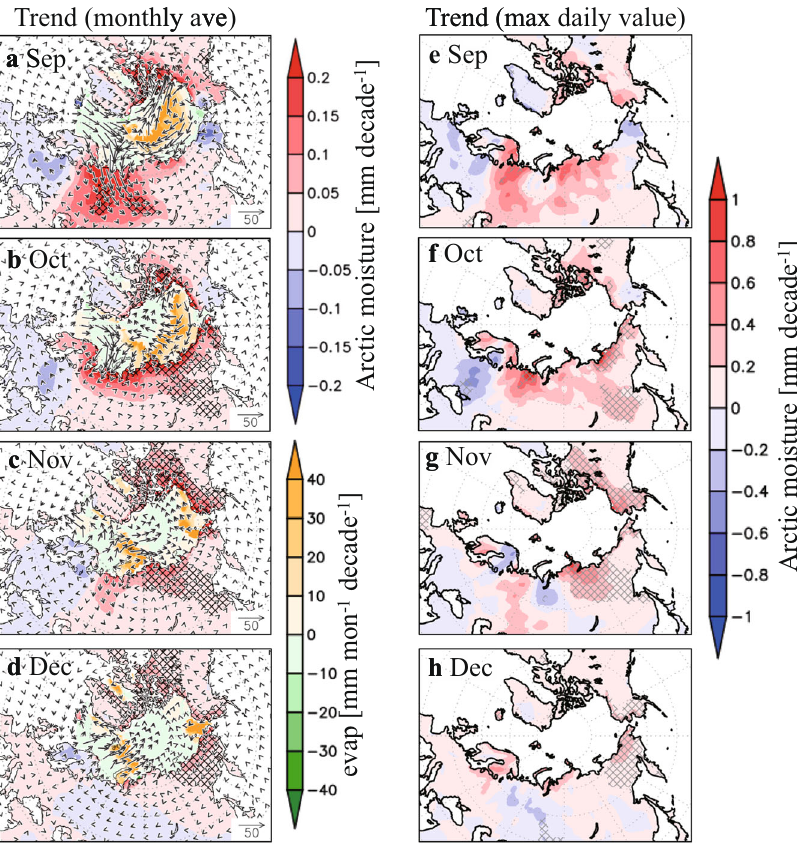
Fig. 4 Trend of monthly-mean Arctic moisture. a – d Linear trends of Arctic moisture for each month (shading over land; mm decade − 1 ) and evaporation (shading over the Arctic Ocean; mm month − 1 decade − 1 ). Vectors are as described in Fig. 3 but for each month. e – h Linear trends of daily Arctic moisture content in terms of their highest value in each year (mm decade − 1 ). Hatching denotes a trend signi fi cant at the 95% con fi dence the mean-state latitudinal gradient of atmospheric moisture content (i.e., drying toward the pole). To better understand the circulation pattern attributable to the recent increase in the fraction of Arctic moisture, we discuss the synoptic fi elds relevant to the periods in which strong moisture transport was detected. Figure 6 shows the daily evolution of the synoptic patterns in advance of the day on which the highest amount of Arctic moisture over eastern Siberia was observed in October (60° – 70°N, 130° – 150°E) and November (60° – 70°N, 110° – 130°E). From Sep- tember 27 to October 1, 2016, a cut-off low centered over northeastern Siberia migrated northeastward (Fig. 6a – c). The counterclockwise circulation around the low strengthened the surface winds over the East Siberian Sea where sea ice was absent (Supplementary Fig. 4a – c). Thus, an air mass with high content of Arctic moisture, created there through evaporation from the ocean, was transported toward Siberia owing to the northerly winds on the western side of the low. Another event with high Arctic moisture occurred on November 18, 2016 (Fig. 6d – f). This case was characterized by a strong northerly wind between an area of low pressure centered around the Sea of Okhotsk and eastern Siberia and an area of high pressure over western Siberia (Fig. 6f). This synoptic situation resembles the pattern designated as Ural blocking, which has received considerable attention regarding Arctic ampli fi cation 20,21 . Before the development of these circulation anomalies, a westerly wind prevailed in parallel with the coastlines of the Barents – Kara seas, which supported the transport of air with high content of Arctic moisture (Fig. 6d, e). There was an ice-free and warm ocean under the region of the